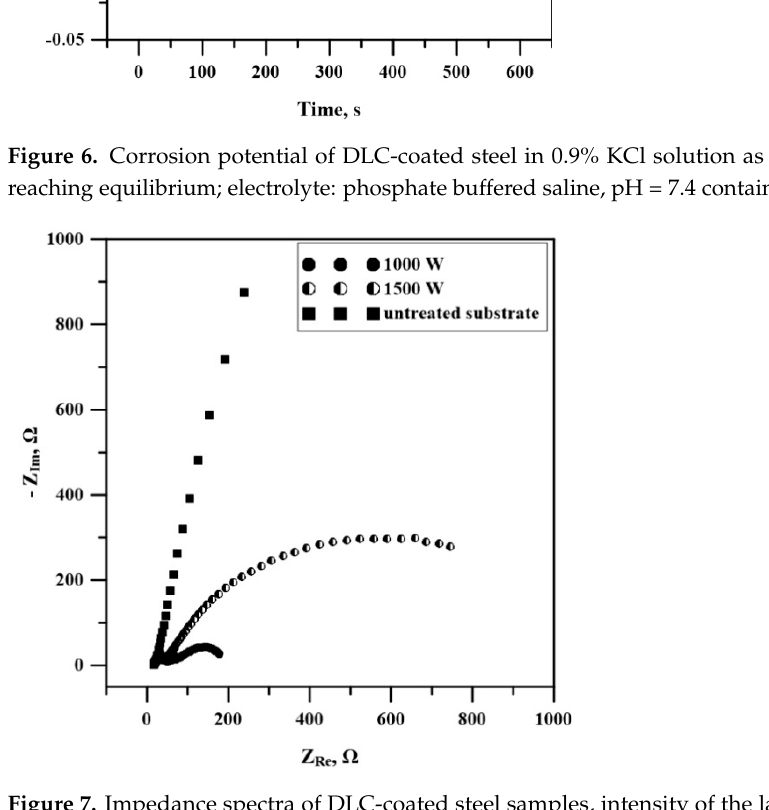
Figure 7. Impedance spectra of DLC-coated steel samples, intensity of the laser beam is indicated close to each spectrum; electrolyte: 0.1 M KCl, containing 5 mM K 4 [Fe(CN) 6 ] and 5 mM K 3 [Fe(CN) 6 ].